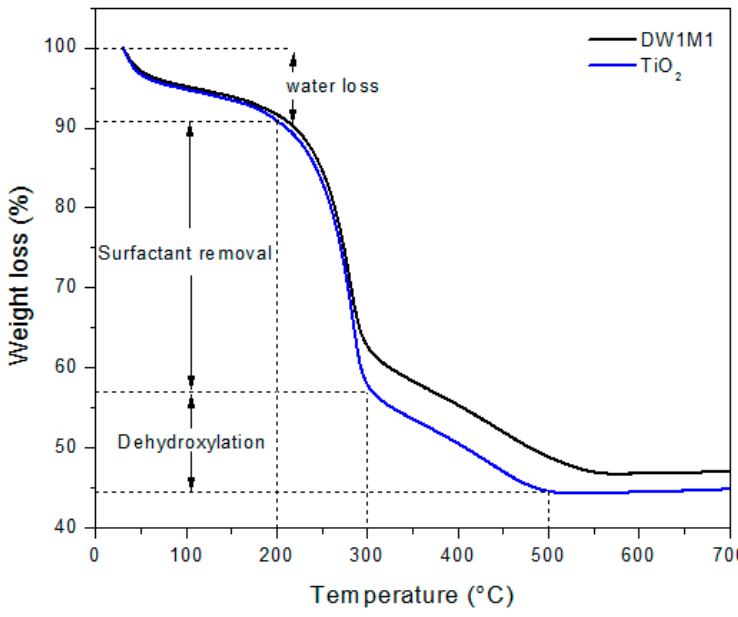
Figure 1. Thermogravimetric analysis of pure TiO 2 and TiO 2 co-doped with 1 wt.% tungsten and molybdenum (DW1M1).